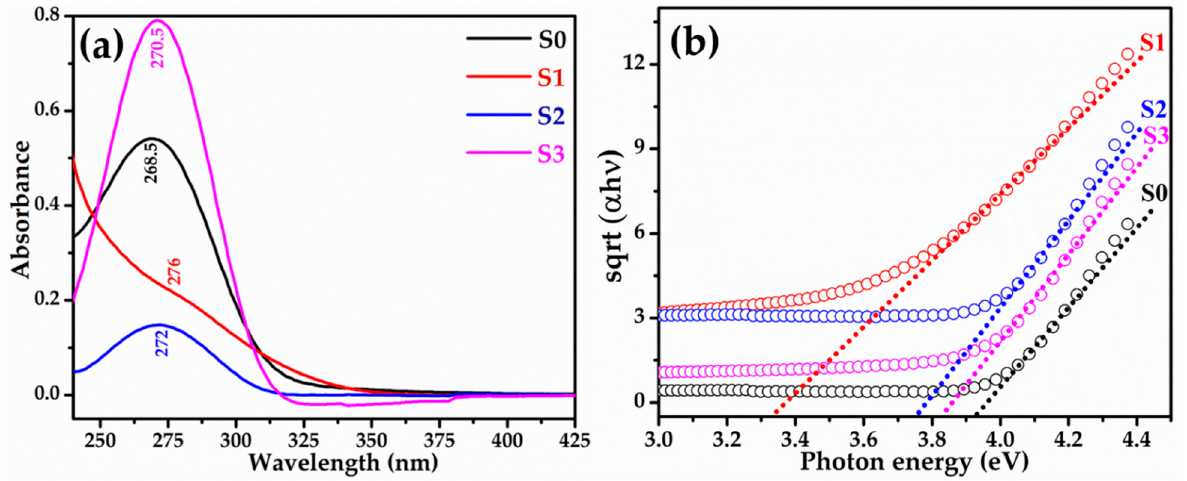
Figure 2. ( a ) Typical UV–vis spectra of pure and Cu-doped TiO 2 nanomaterials and ( b ) their corresponding Tauc’s plots. sponding Tauc’s